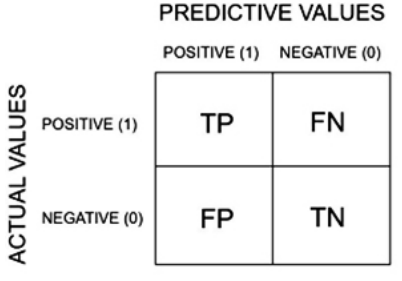
Figure 2. Matrix confusion.